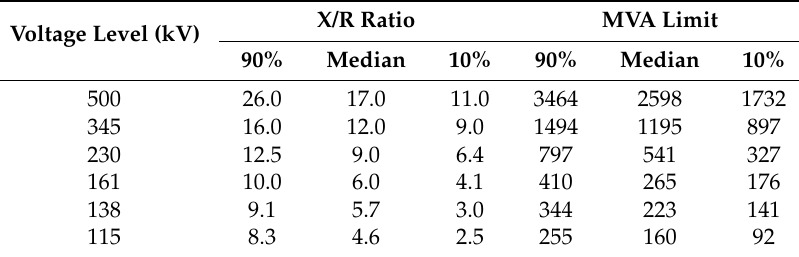
Table 4. Transmission line X/R ratio and MVA limit, for